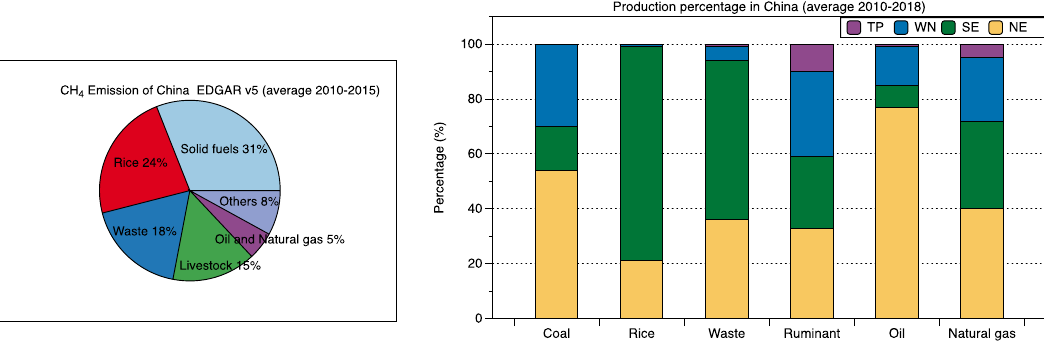
Figure 3. Prior anthropogenic CH 4 emission from sectors and related production percentage in four